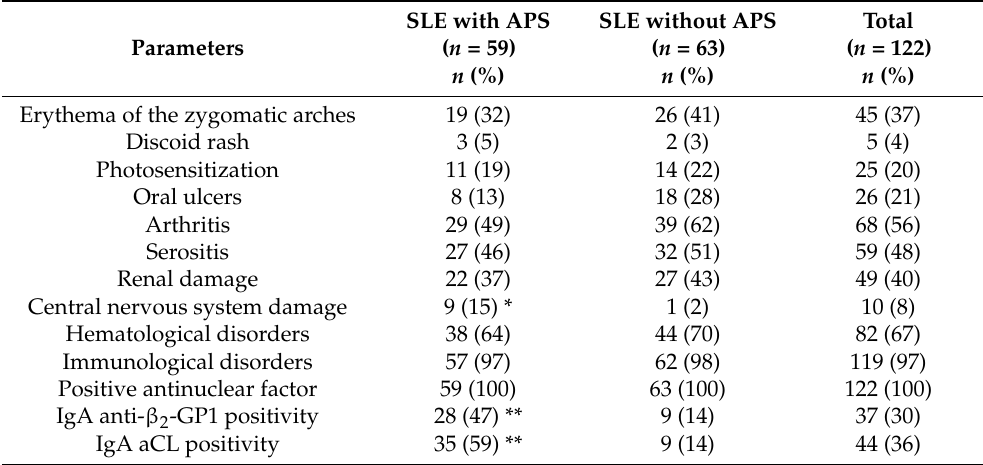
Table 4. Clinical and laboratory manifestations of systemic lupus erythematosus over the entire period of the disease according to 1997